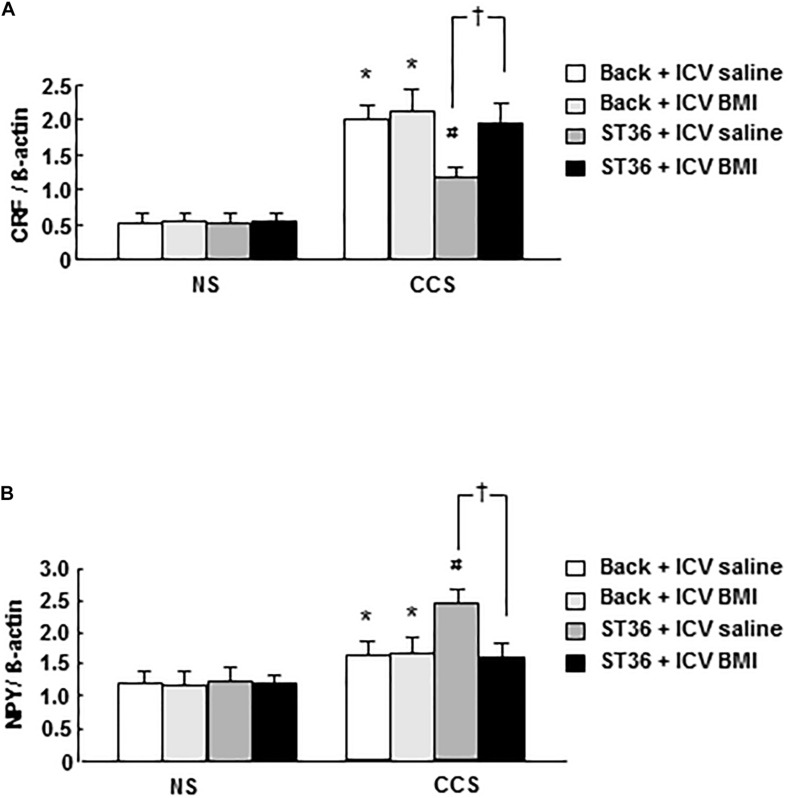
Effects of EA at ST-36 and GABAA receptor antagonist on central CRF mRNA expression (A) and NPY mRNA expression (B) in response to CCS. (A) In the NS groups, CRF mRNA expression showed low level, EA at back (with ICV administered saline or BMI) did not change the CRF mRNA expression significantly. However, EA at ST-36 (with ICV administered saline or BMI) also did not change the CRF mRNA expression significantly. In the CCS conditions, CCS highly elevated the CRF mRNA expression in the sham group (EA at back, and saline ICV administered). In the EA at back groups, ICV administered BMI did not change the CRF mRNA expression significantly. However, in the EA at ST-36 groups, the reduced CRF mRNA expression was significantly increased by ICV administered BMI. (B) In the NS groups, NPY mRNA expression showed low level, EA at back (with ICV administered saline or BMI) did not change the NPY mRNA expression significantly. However, EA at ST-36 (with ICV administered saline or BMI) also did not change the NPY mRNA expression significantly. In the CCS conditions, CCS elevated the NPY mRNA expression in the sham group (EA at back, and saline ICV administered). In the EA at back groups, ICV administered BMI did not change the NPY mRNA expression significantly. However, in the EA at ST-36 groups, the further significantly increased NPY mRNA expression (saline ICV administered), was significantly inhibited by ICV administered BMI (n = 6, *P < 0.05 compared with NS non-treated group, #P < 0.05 compared with CCS non-treated group, †P < 0.05 compared with CCS ST36 + ICV saline group).